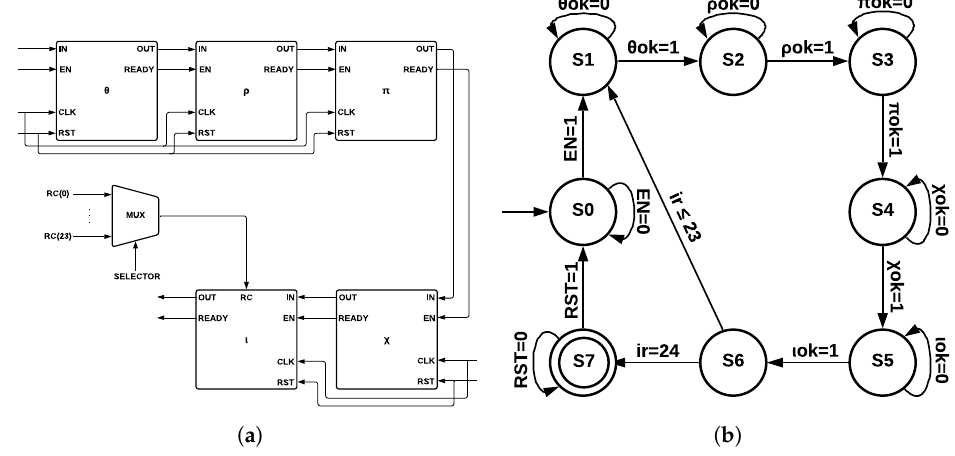
Figure 7. ArchMM at Round level and ArchMM state machine at KECCAK-p level. ( a ) ArchMM at Round level. ( b ) ArchMM state machine at KECCAK-p